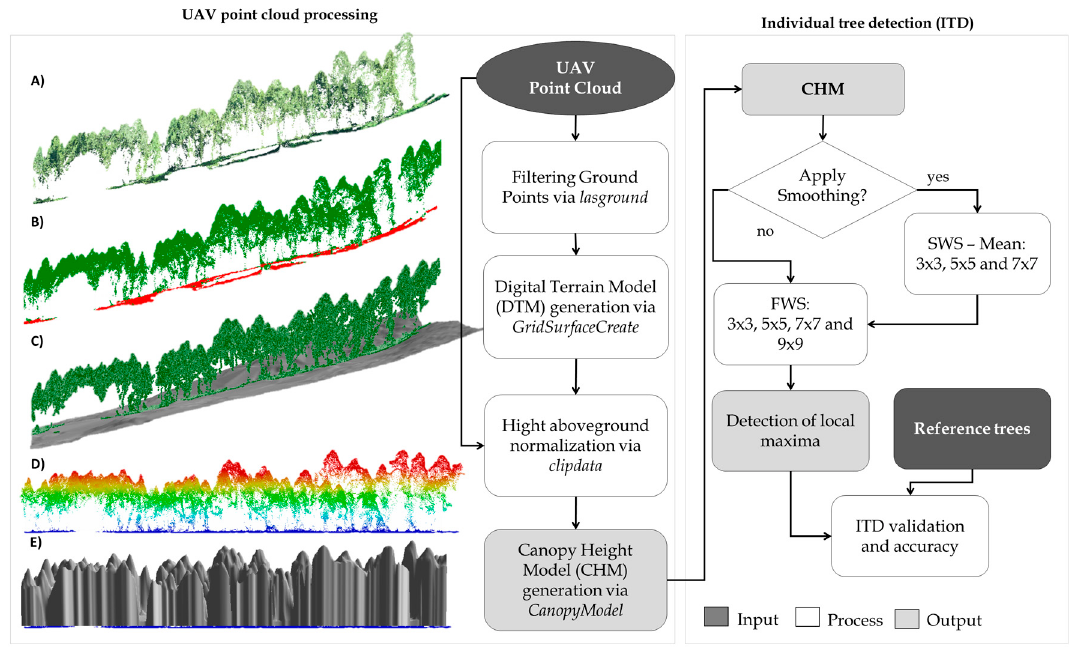
Figure 2. Workflow of the UAV data processing and individual tree detection. ( A ) UAV-derived point cloud; ( B ) Classified ground points; ( C ) Digital Terrain Model (DTM); ( D ) UAV-point cloud height normalization; ( E ) Canopy Height Model (CHM).